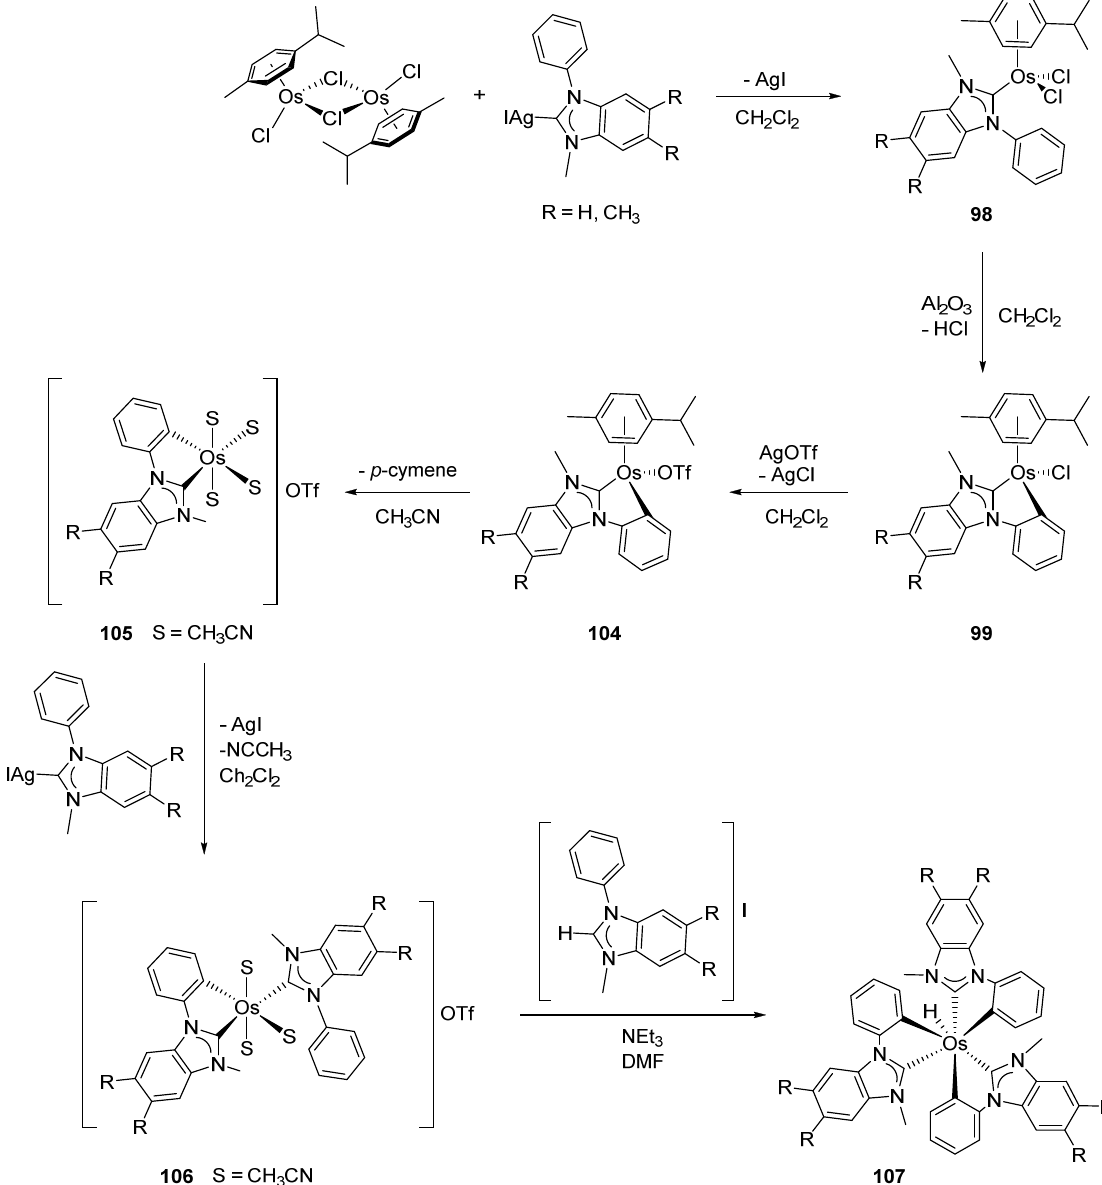
Figure 22. Synthesis tris -cyclometalated complex from the osmium dimer precursor.